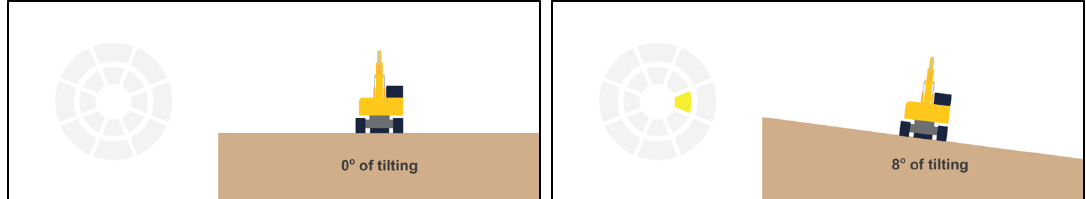
Figure 16. The revised concept of center of gravity. Note that the segment in the center of the concept, which indicates if the machine is in a stable position, has been removed. The left image shows that when the machine is in a stable position, all segments are turned off. As shown in the right image, one of the segments will be turned on only when the machine started to